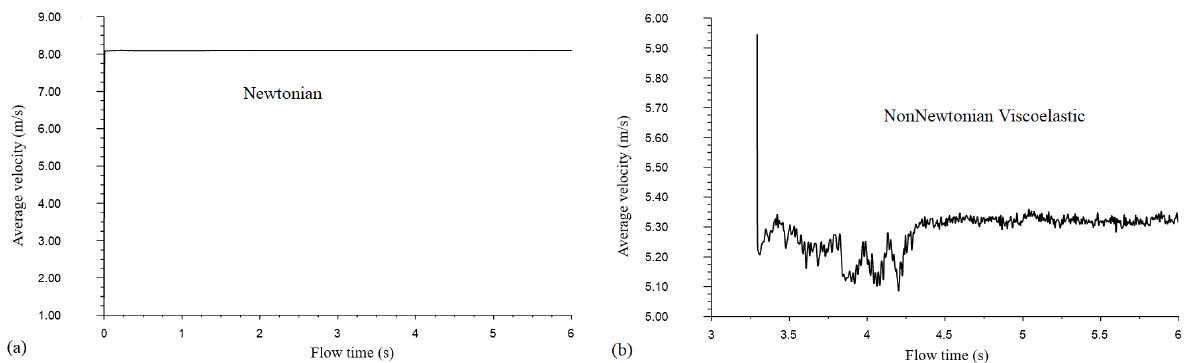
Figure 4. Average velocity at the exit of the blade channel for ( a ) Newtonian and ( b ) non-Newtonian viscoelastic fluids.